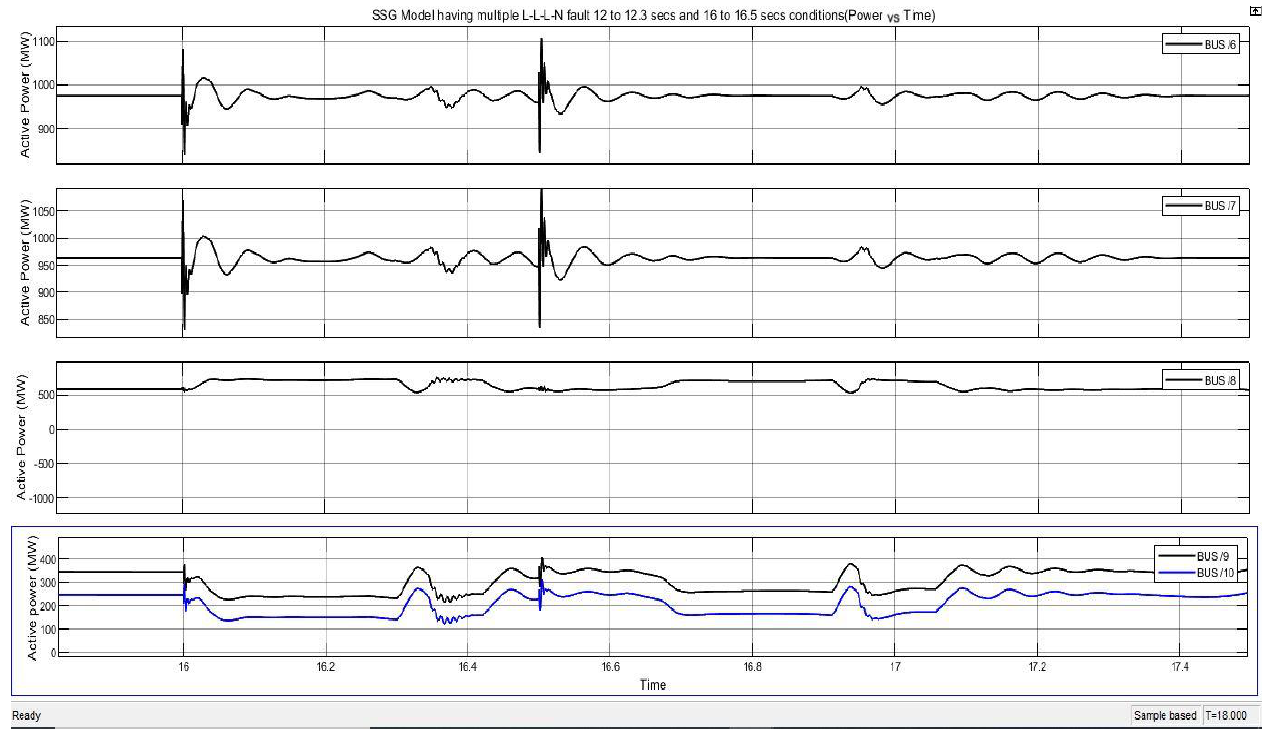
Figure 32. Multiple line-to-line (L-L-L-N) faults are inserted in the system from 16 to 16.5 s (Bus 1 to Bus 5).